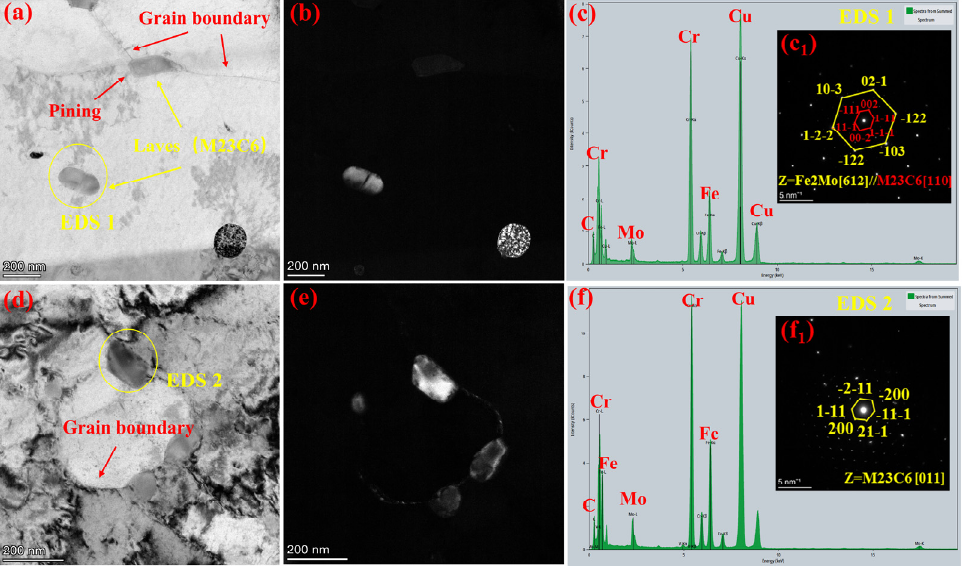
Figure 8. EDS and SAED images for the precipitates of T91 steel creep at ( a – c ) 650 °C and ( d – f ) 700 °C .